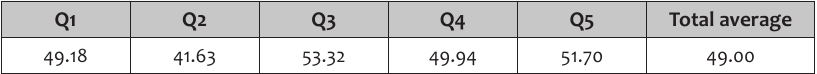
Table 2: Achievement of learners in quintiles as percentages